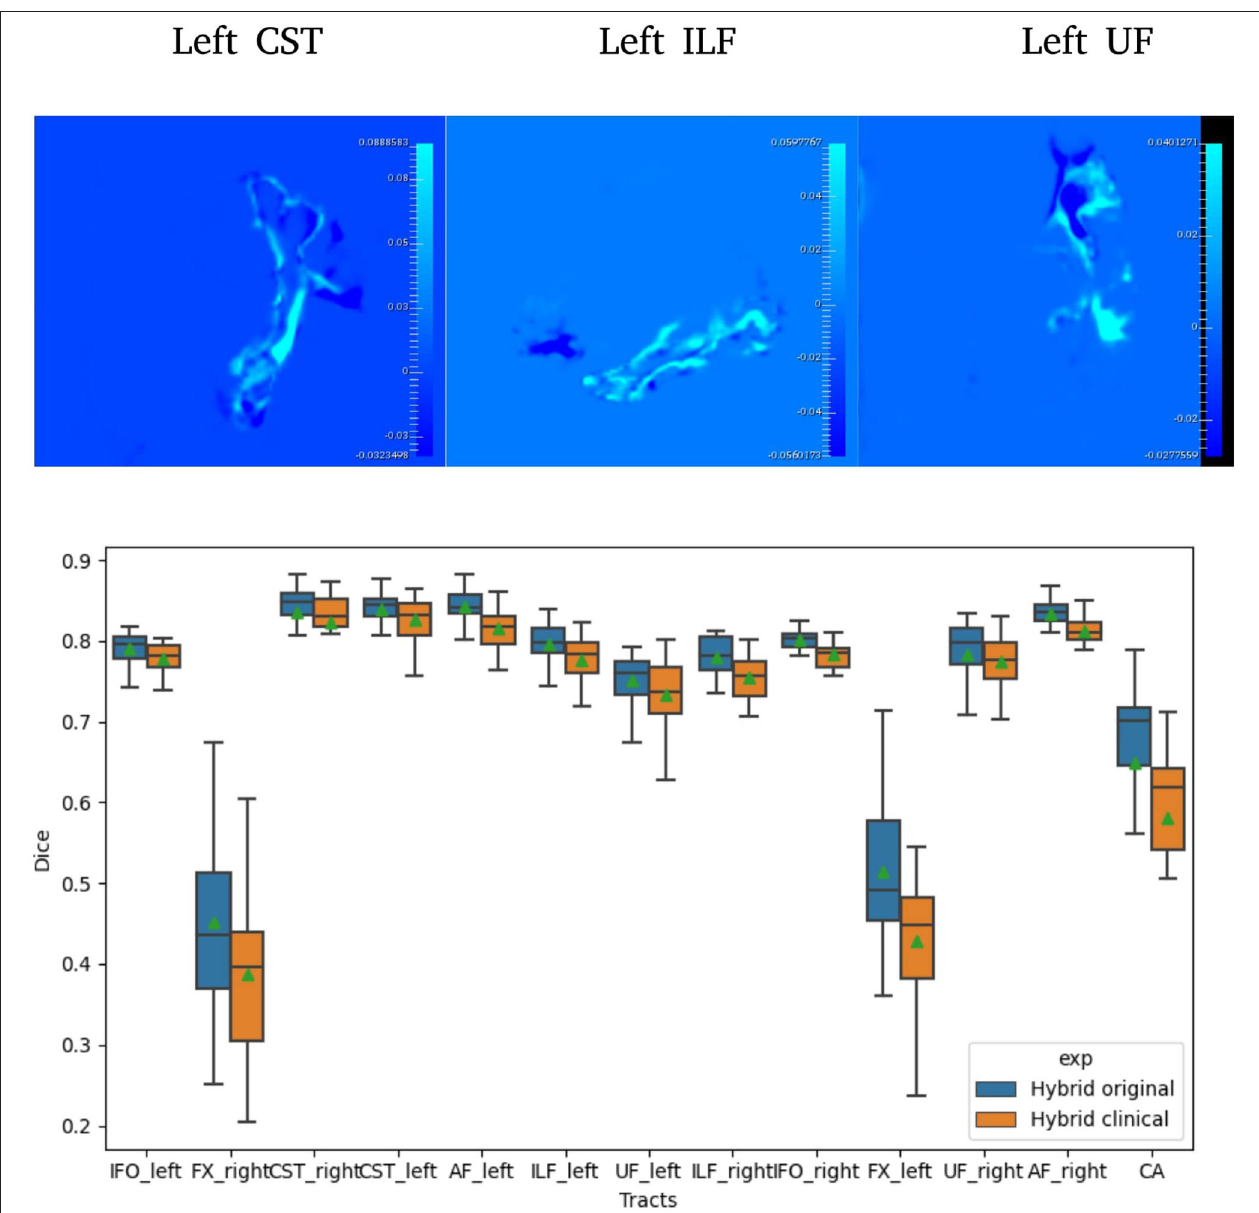
FIGURE 2 | Difference between Hybrid the SDs of the predicted probabilities (Uncertainties) computed on original and clinical data (top). A selection of Dice distribution for 13 select tracts is computed across all 105 subjects